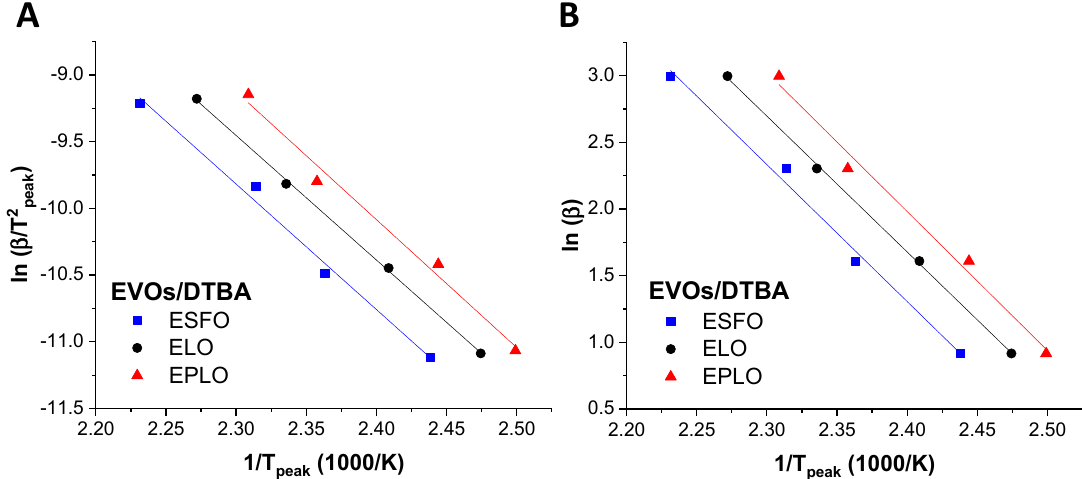
Figure 3. Linear plot based on ( A ) the Kissinger equation and ( B ) the Ozawa kinetic method for the EVOs/DTBA curing systems. Table 2. Kinetic parameters determined by fitting non-isothermal DSC data.